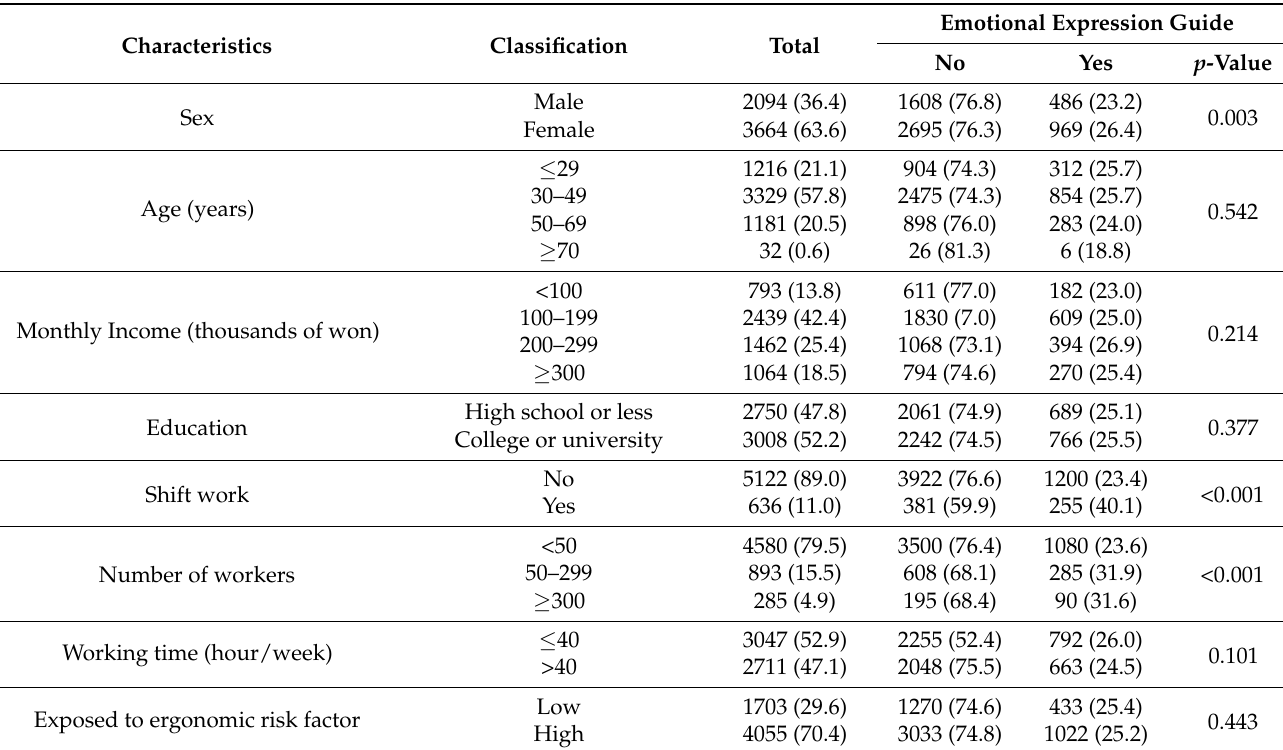
Table 1. General characteristics of participants ( n = 5758).